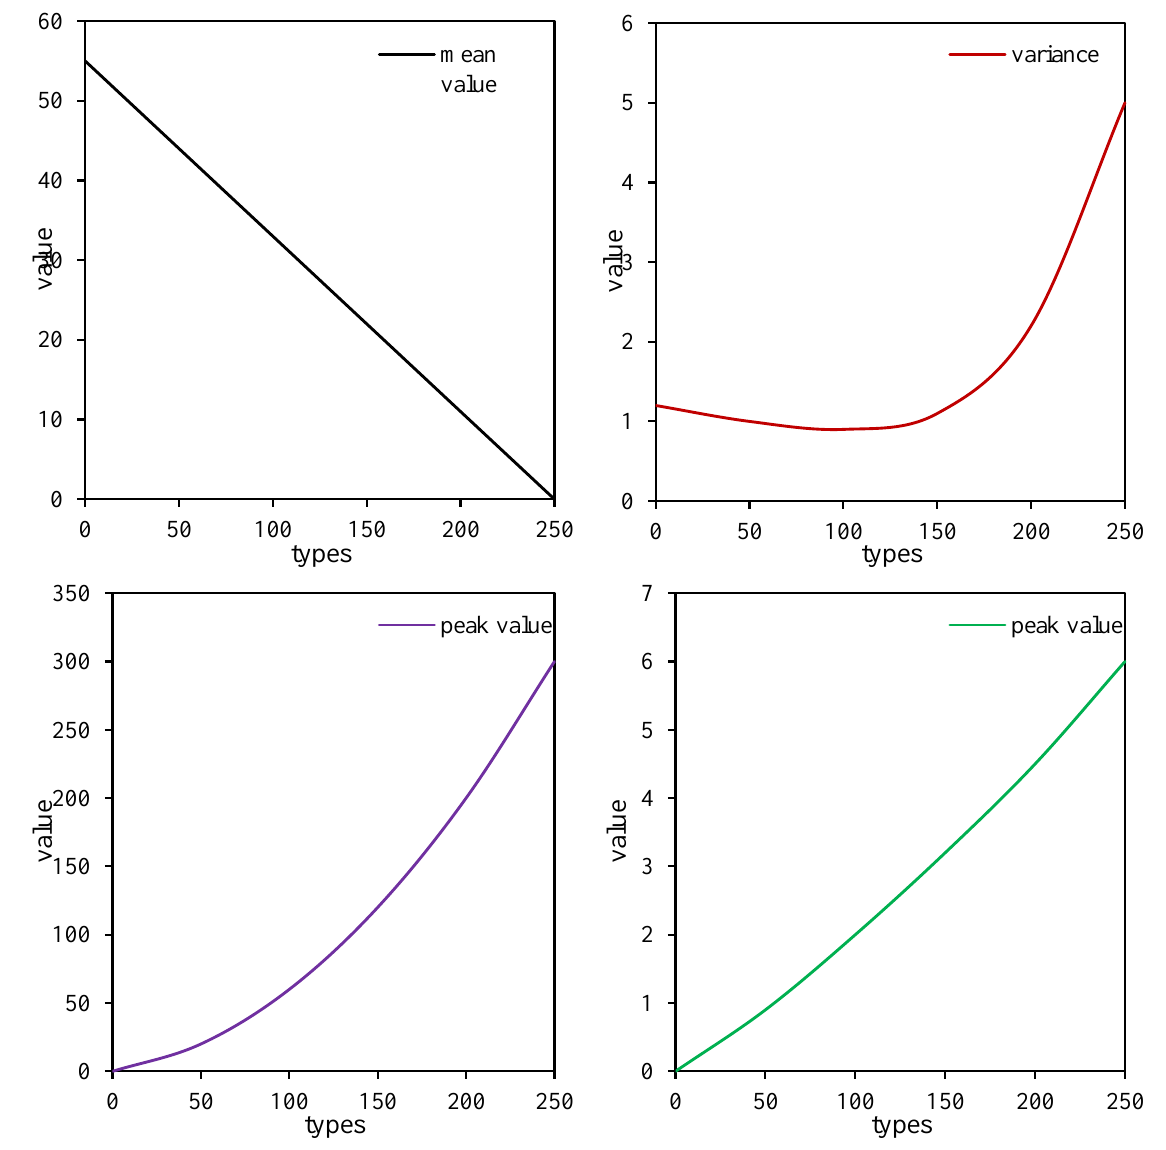
Figure 6. Partial characteristic change curve. Table 2. Sample mean